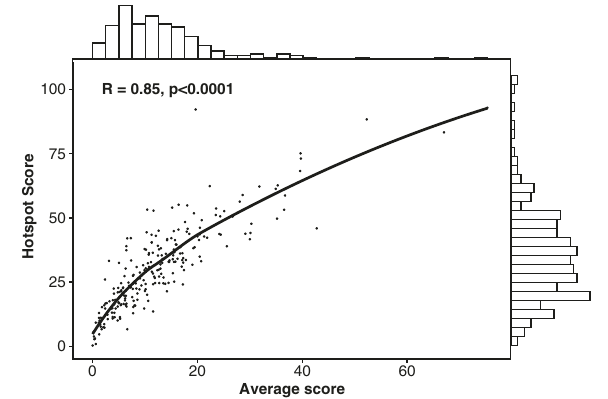
Fig. 1 Distribution and correlation between Ki67 labeling indexes. Each dot represents individual cases. Solid line represent Loess smoothing fi t of the data. The bar graph on X- axis represents distribution of the average score. The bar graph on Y- axis represents distribution of the hotspot score. R = Pearson correlation coef fi